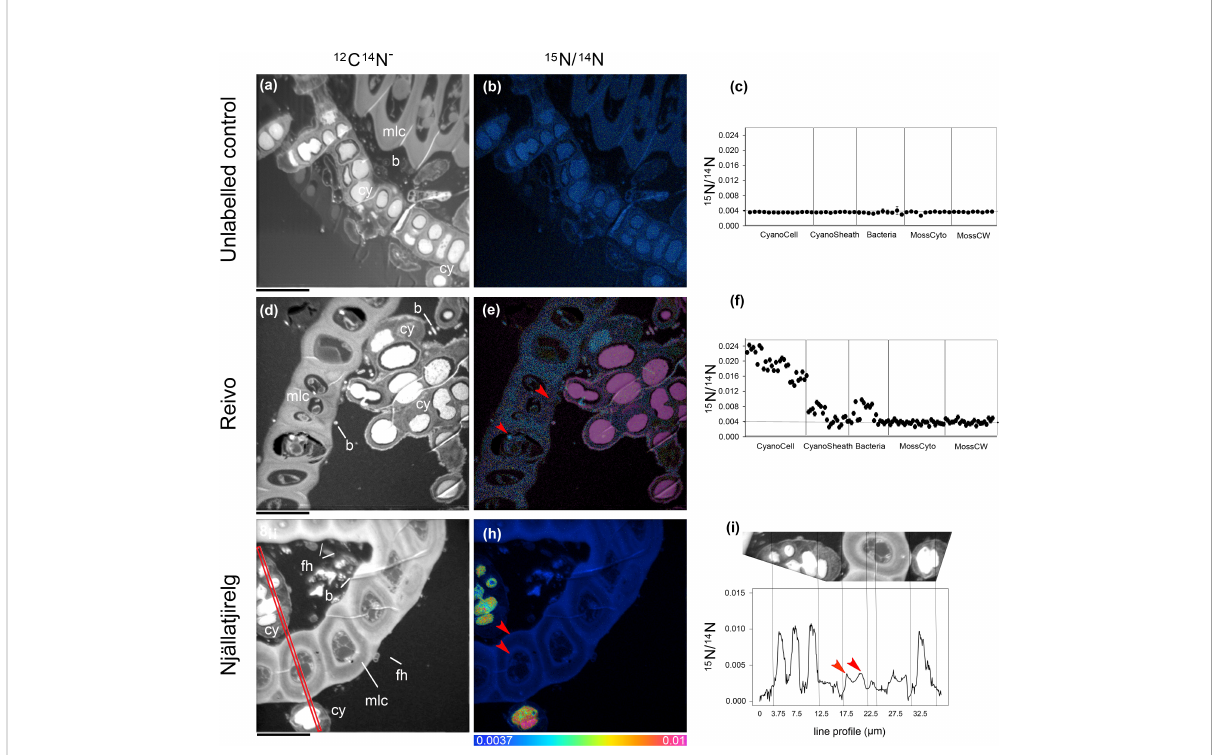
FIGURE 2 Spatial distribution of 15 N accumulation in younger dark green segments of Pleurozium schreberi shoot and associated microbiome. 15 N concentration ( 15 N/ 14 N) of representative samples of an unlabeled shoot (A – C) and shoot labeled with 15 N 2 and incubated for one week (Reivo forest site d-f; Njällatjirelg forest site g-i). 15 N enrichment can be distinguished in cyanobacteria cells (CyanoCell) and in the moss cell wall (MossCW) and cytoplasm (MossCyto) in both forest sites (f and red arrow in e, h and i for moss cells). Epiphytic bacterial cells in direct contact with cyanobacteria can be seen enriched in 15 N (D – F) . Fungal hyphae attached to the moss leaf close to the cyanobacteria cells can be distinguished (G) . Cellular structures are visible in the greyscale 12 C 14 N images (A, D, G) , with corresponding 15 N/ 14 N (B, E, H) images re fl ecting levels of 15 N enrichment. The HSI colour scale (0.0037 – 0.01; 15 N/ 14 N natural abundance = 0.0037) applies to all HSI images. Dots and line scans show numerical levels of 15 N enrichment ( 15 N/ 14 N) across the subcellular regions (C, F, I) , with data acquired from the line (512 × 512 pixels) (I) indicated on the respective 12 C 14 N image (G) . Structural features: cyanobacteria (cy), bacteria (b), fungal hyphae (fh), and moss leaf cell (mlc). Bars, 10 µm (for all